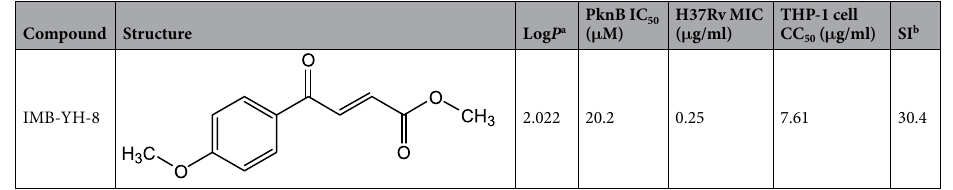
Table 1. Structure, Log P , enzyme inhibition activity against PknB, anti-tuberculosis activity, and selectivity of IMB-YH-8. a Log P determined with Discovery Studio 2.5. b SI, selectivity index, calculated as the CC 50 /MIC.